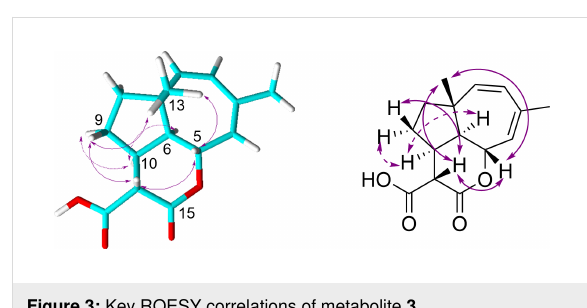
(dd, J = 11.4, 4.0 Hz, H-14a) and 4.10 (dd, J = 11.4, 6.4 Hz, H-14b)] and carbons at δ C 53.4 (C-11), 82.5 (C-10), and 175.6 (C-15) (see Table 1 and Supporting Information File 1).